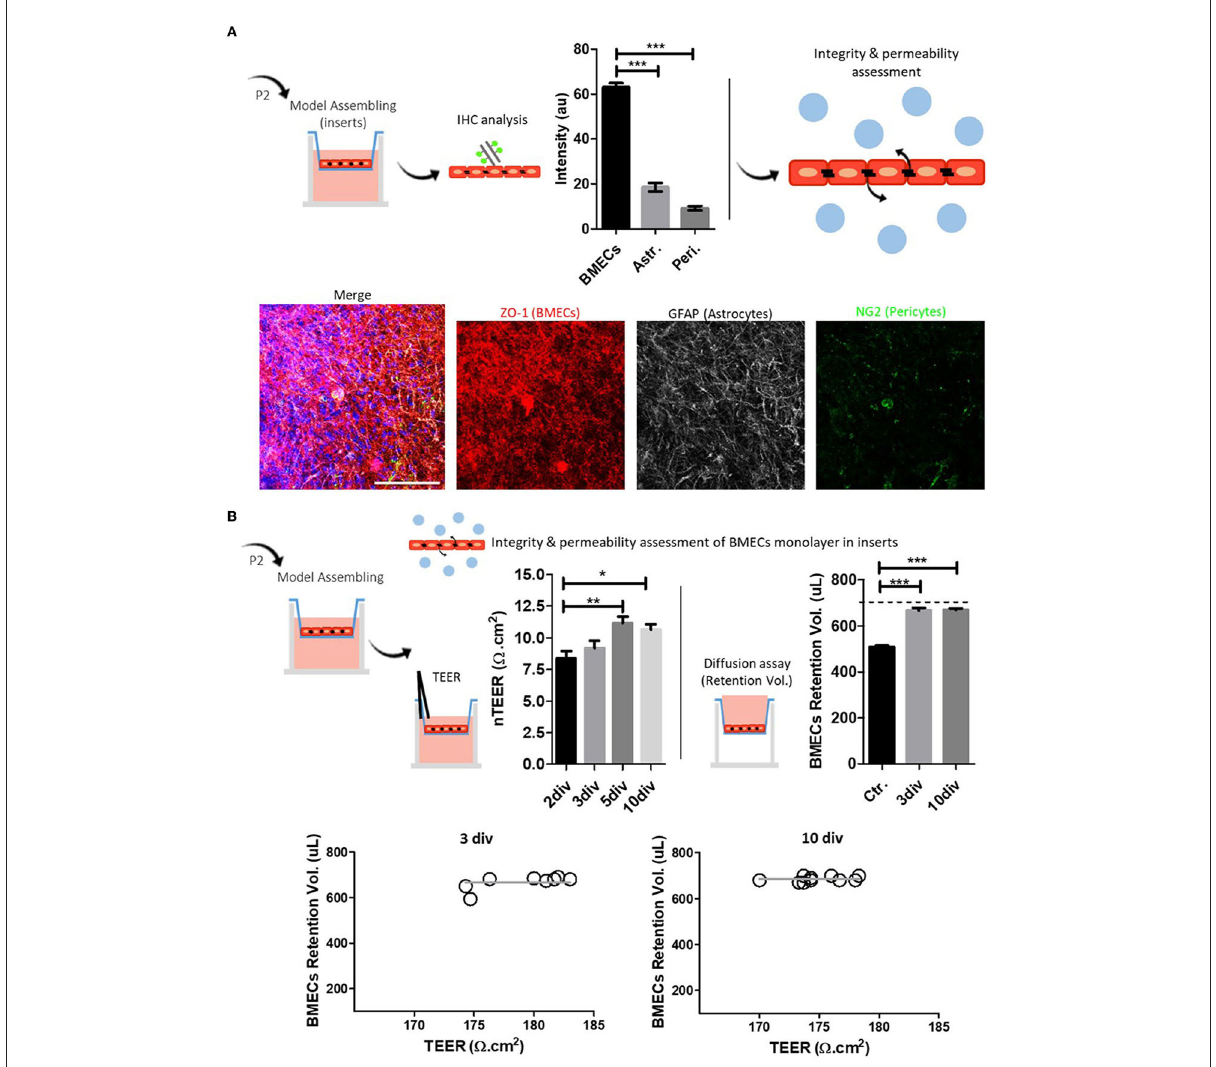
FIGURE3 BMECs primary culture and model assembling in inserts. (A) Schematic representation of the methodology for the characterization of BMECs primary culture and representative composite confocal images of ZO-1/NG2/GFAP labeling; Quantitative analysis shows an increased proportion of BMECs (ZO-1). Astrocytes (GFAP) and pericytes (NG2) are also recognized. (B) Integrity and permeability assessment of the BMECs monolayer in inserts. Schematic representation of TEER and diffusion assay. TEER results gradually increased, reaching the highest value at 5